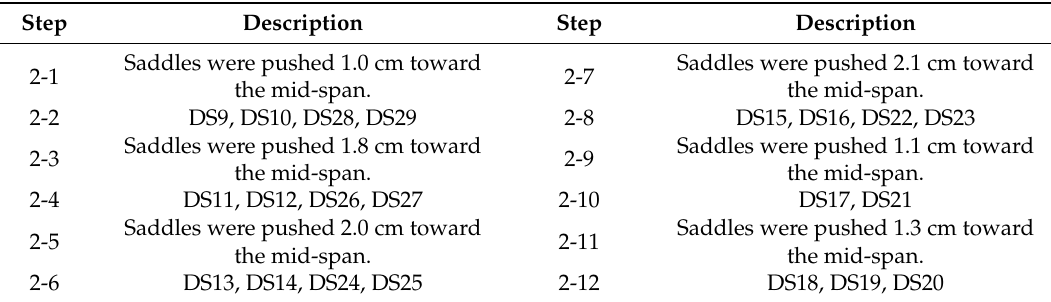
Table 4. Specific step of tensioning round